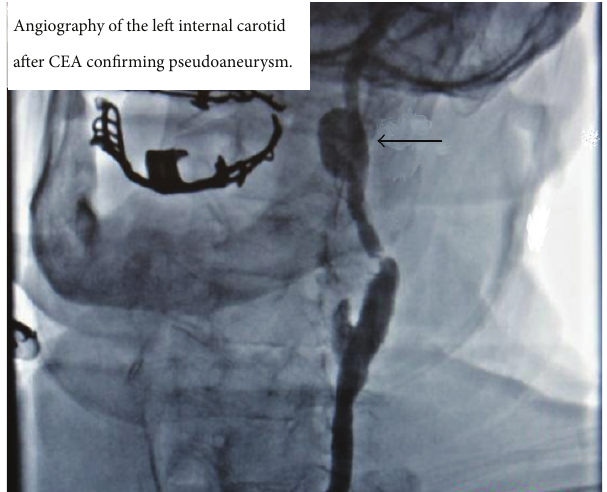
Figure 3: Poststenting percutaneous transluminal angiography; stent graft placement is seen with angiography.